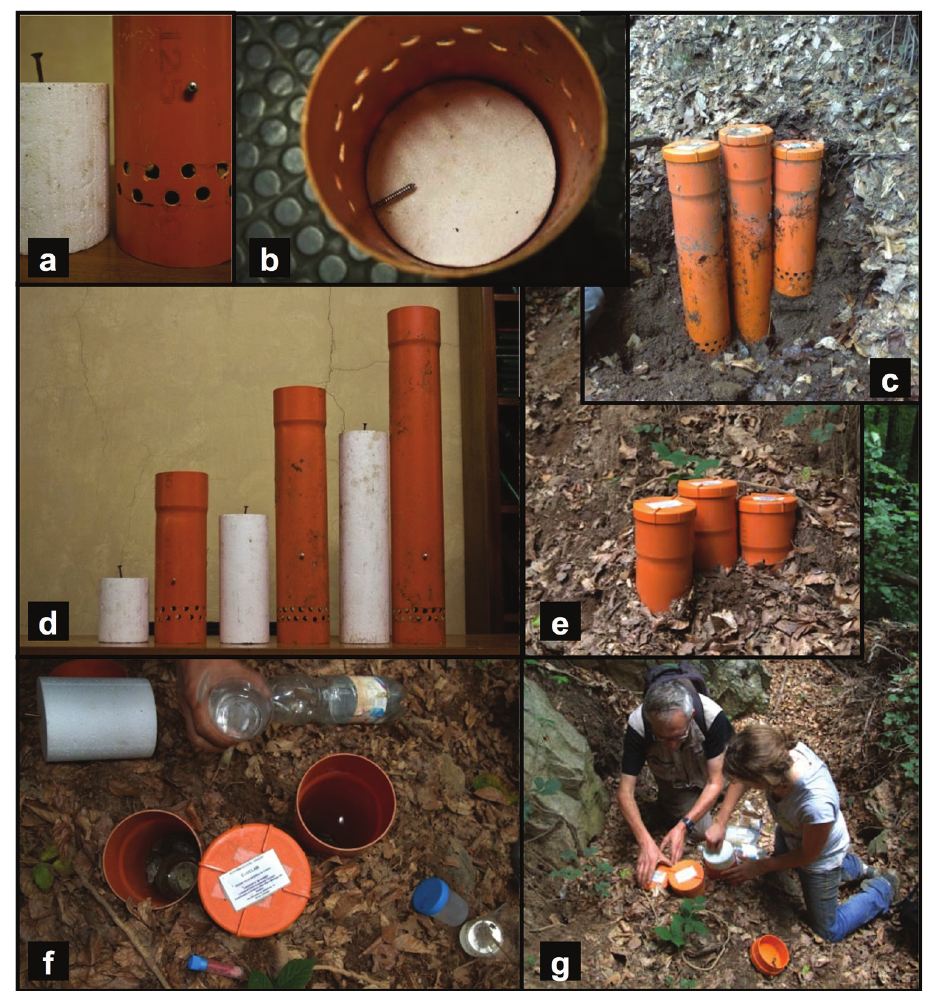
Figure 3. a sampling holes (details) b Blocking screw c installation of an MSS-triplet d SSD of three different length e MSS-triplet buried in the ground f, g renewing the pitfall trap inside the SSD. Photo credits: Elena